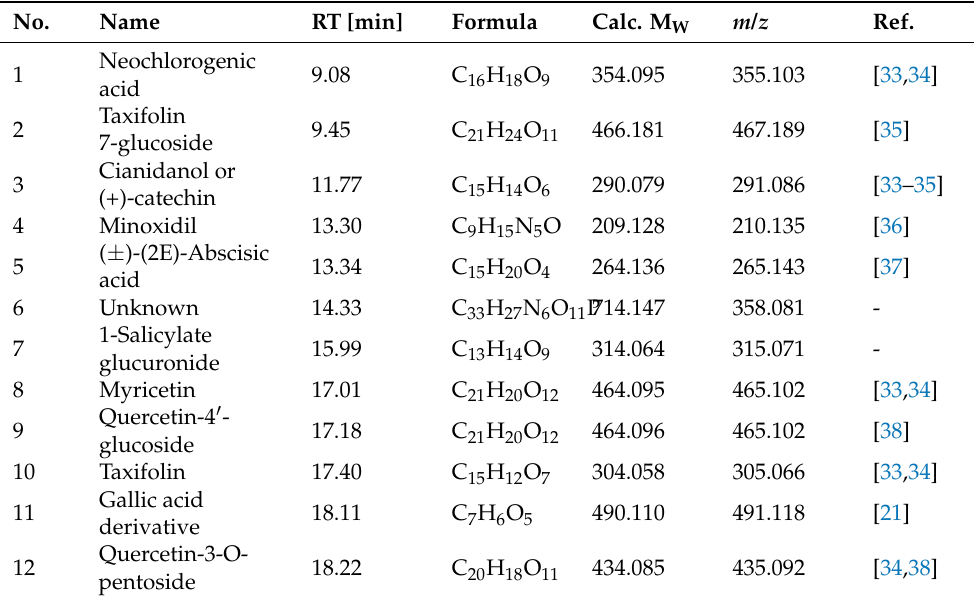
Table 3. Chemical compounds identified in polar extracts of various varieties of walnut husk by ultra-high performance liquid chromatography in-line with a photodiode array detector and an orbitrap mass spectrometer